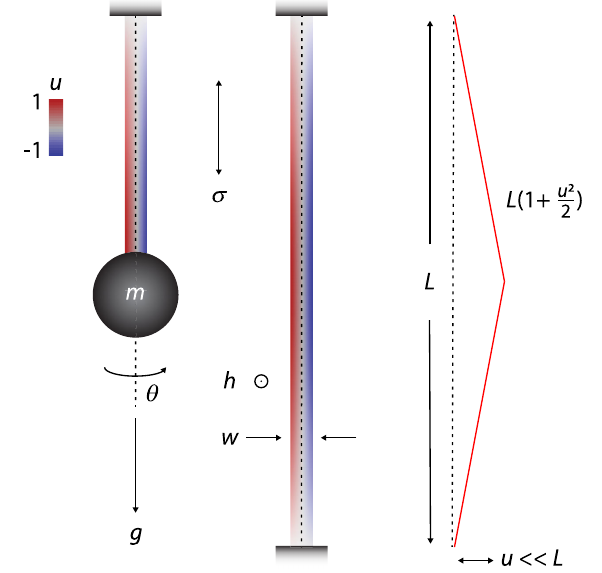
FIG. 1. Dissipation dilution of a torsion resonator. Left: a torsion pendulum formed by suspending a mass m from a ribbonlike fiber of width w and thickness h . Gravity loads the fiber into tension mg , producing a tensile stress σ ¼ mg=wh . The color gradient represents the transverse displacement u of the fundamental torsion mode. Center: a doubly clamped ribbon under tensile prestress σ . Right: bifilar model of the ribbon ’ s torsion mode [21]. In both cases, the ribbon length L is preserved to first order, leading to dissipation